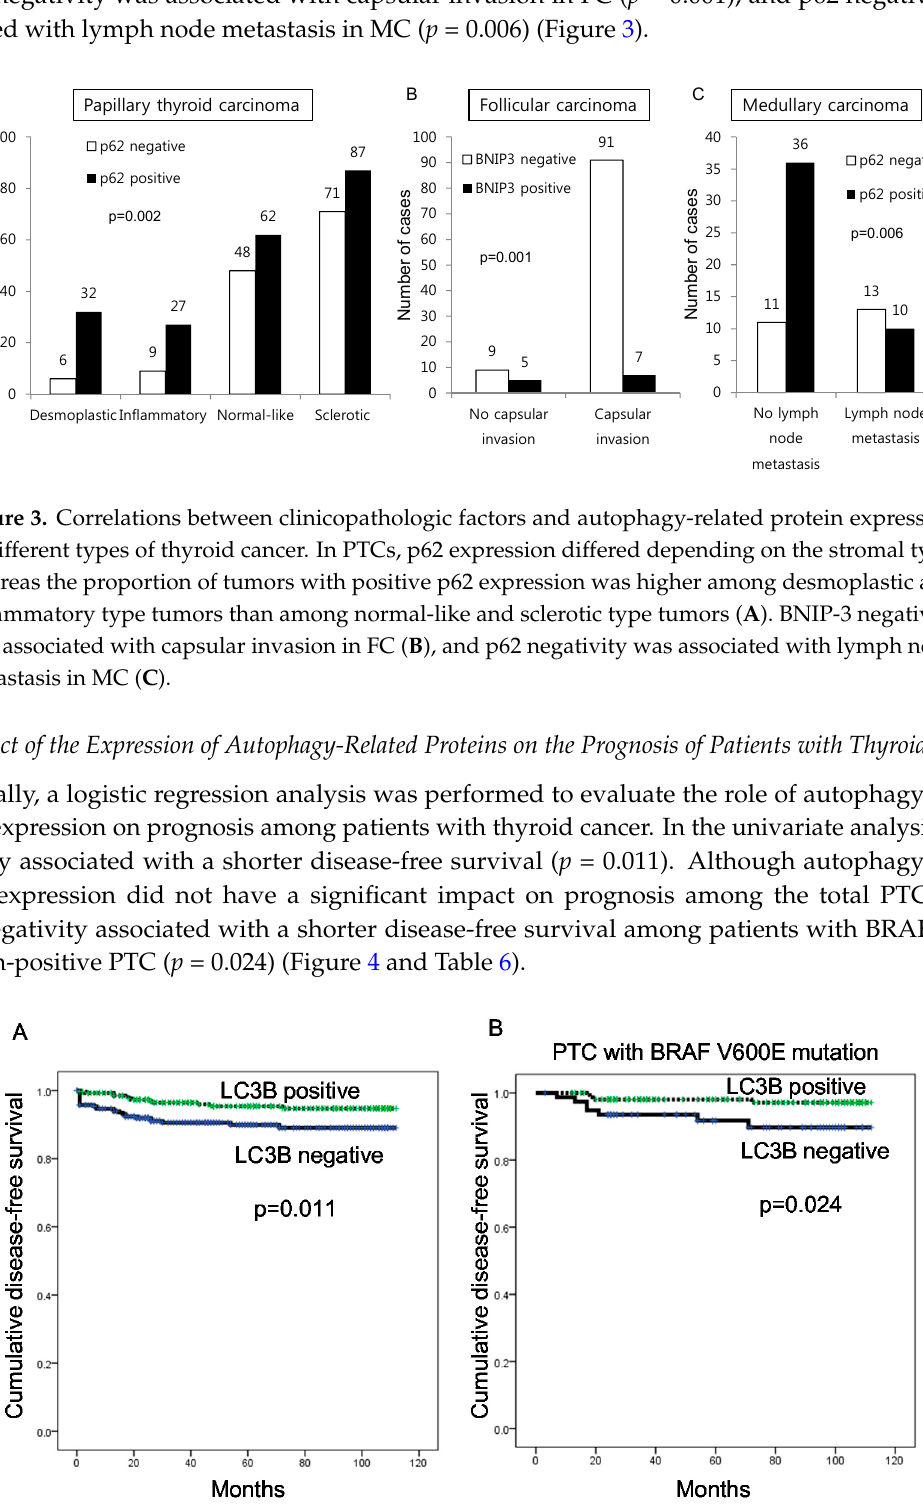
Figure 4. Disease-free survival among all patients with thyroid cancer ( A ); and among those with papillary thyroid carcinoma (PTC) with the V600E mutation ( B ), according to the LC3B expression status.